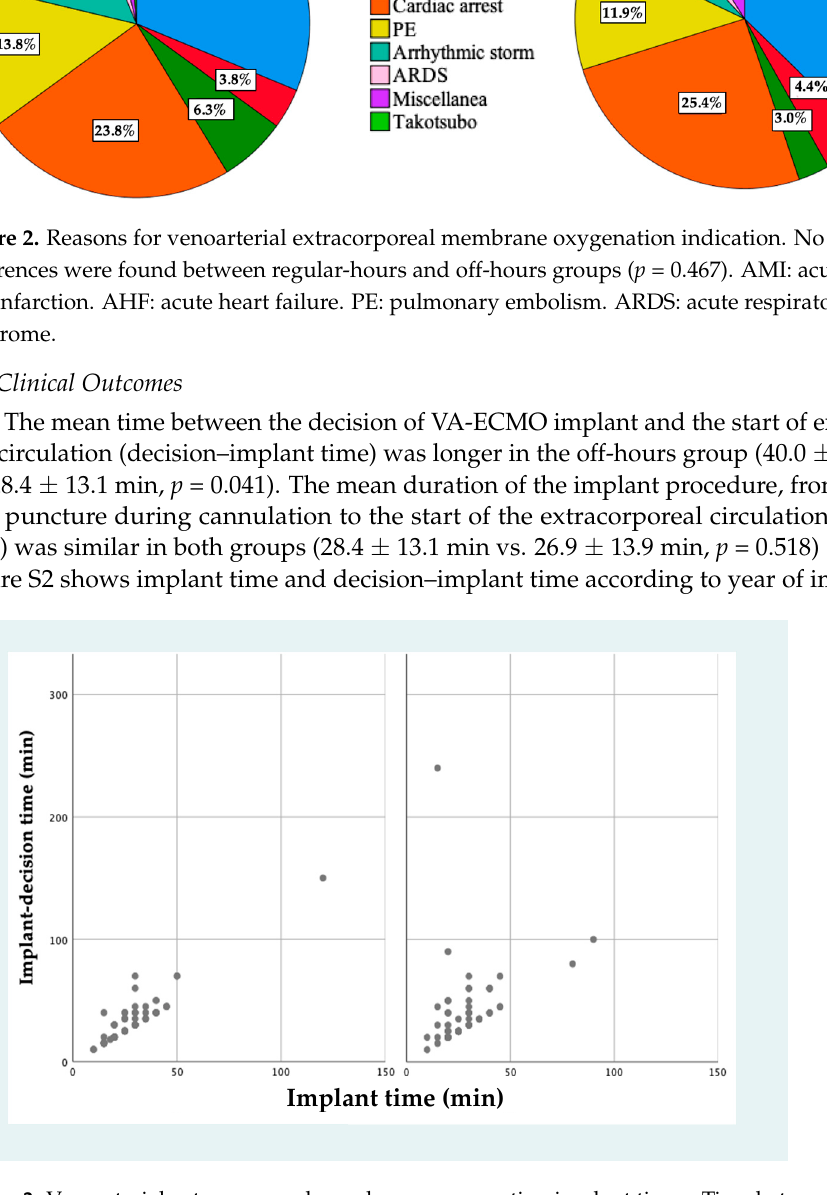
Figure 3. Venoarterial extracorporeal membrane oxygenation implant times. Time between venoarterial extracorporeal membrane oxygenation implant decision and the end of the implant procedure was slightly higher in off-hours group (40.0 ± 30.7 min vs. 28.4 ± 13.1 min, p = 0.041), without differences in implant procedure Implant time (min)